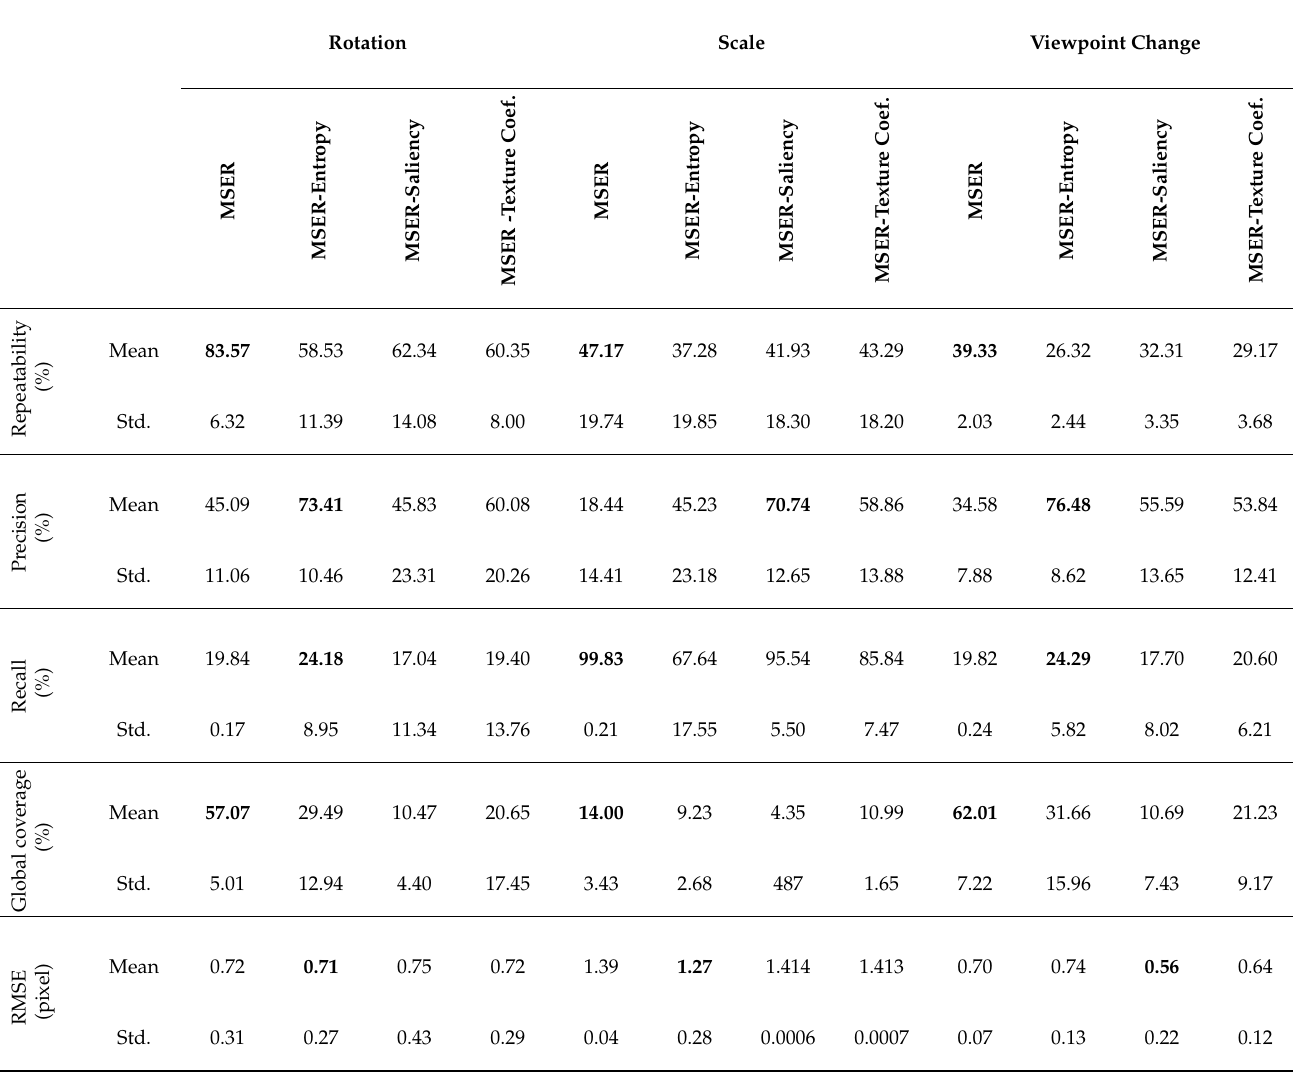
Table 3. The matching results of MSER detector in synthetic images. Rotation Scale Viewpoint